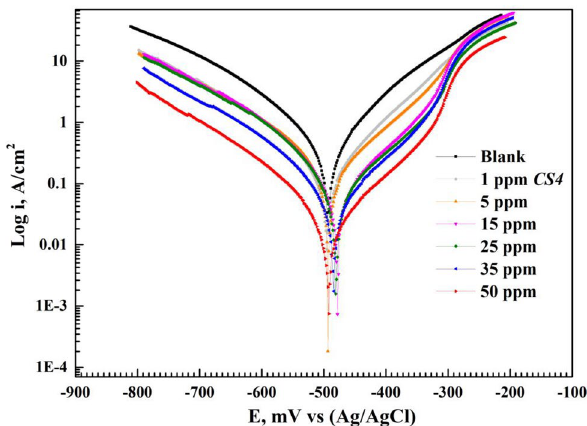
Figure 7. I-V curves for CS -metal in 1 M HCl with and without various concentrations of CS4 at room temperature.